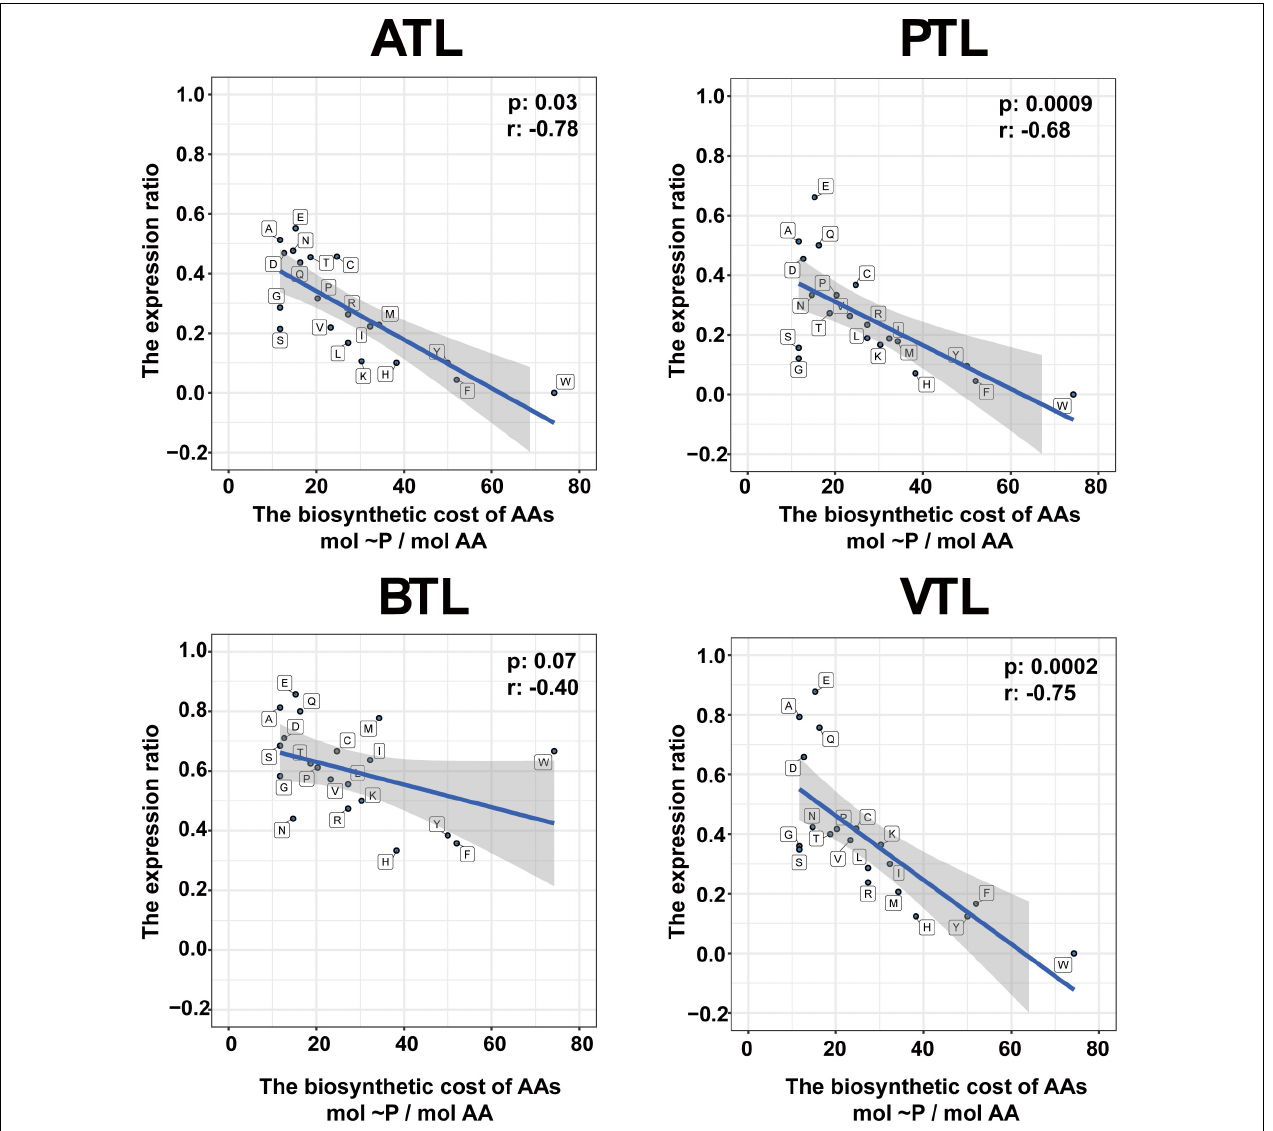
FIGURE 4 | Relationship between the amino acid expression ratio and biosynthetic cost of each amino acid. The ATL, PTL, BTL, and VTL represent the thermophilic methanogenic chemostats supplemented with acetate, propionate, butyrate, and isovalerate as sole carbon source, respectively. The shaded area represents the 95% confidence region. The biosynthetic cost of each amino acid is represented by the number of high-energy phosphate bonds sacrificed in the biosynthetic pathway (Akashi and Gojobori, 2002). The expression ratio is defined as follows: Expressionratio = N ( NAG MT ) N ( MAG . N (MAG MT ) represents the number of MAGs in which MG ) the genes responsible for the synthesis of the corresponding AA were actively transcribed. N (MAG MG ) is the number of MAGs that contain all the genes required for synthesizing the corresponding AA. Abbreviations of the amino acids: alanine (A), arginine (R), asparagine (N), aspartate (D), cysteine (C), glutamine (Q), glutamate (E), glycine (G), histidine (H), isoleucine (I), leucine (L), lysine (K), methionine (M), phenylalanine (F), proline (P), serine (S), threonine (T), tryptophan (W), tyrosine (Y), and valine